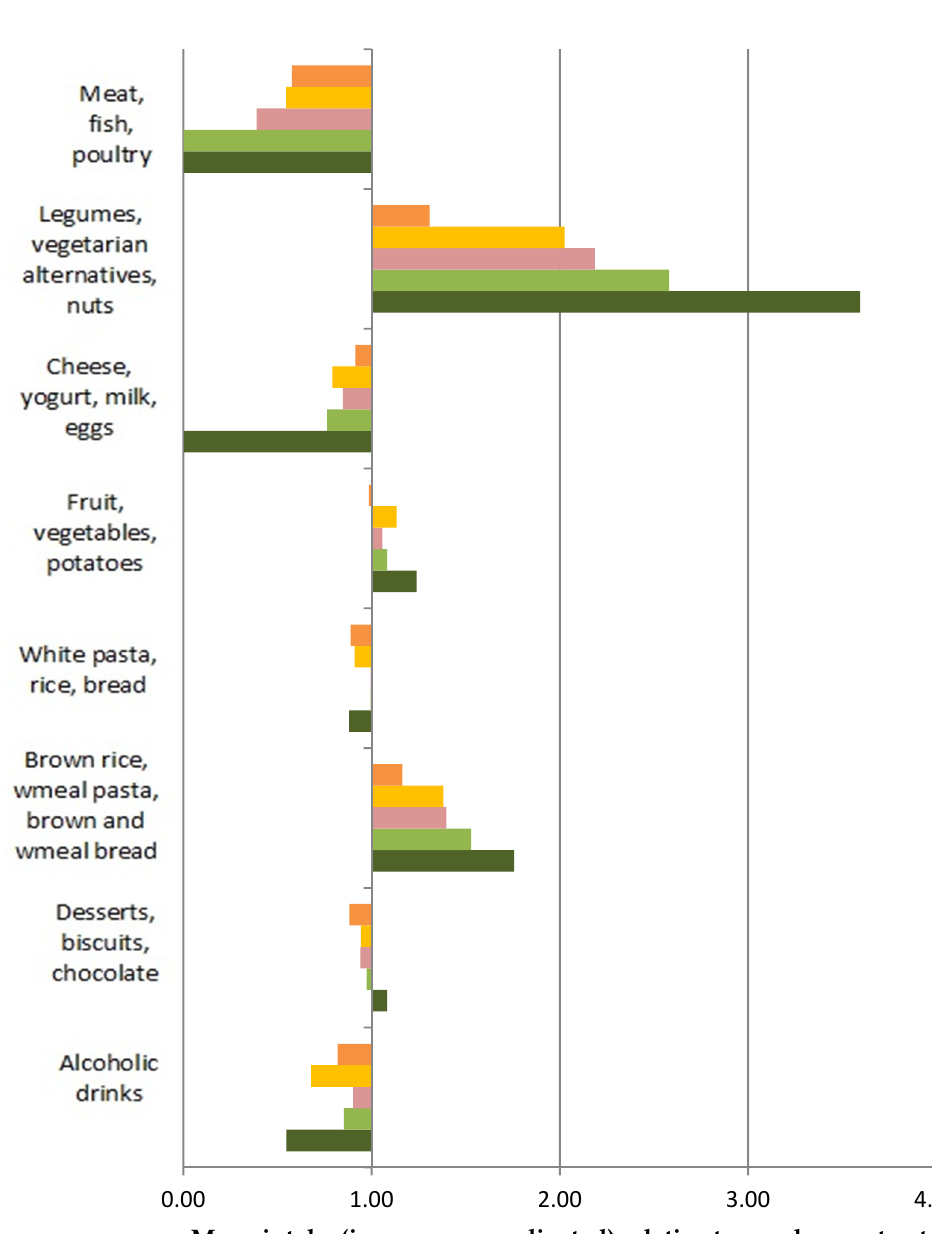
Figure 1. Relative age-adjusted mean (g) consumption of foods in low meat-eaters, poultry-eaters fish-eaters, vegetarians and vegans compared to regular meat-eaters among men.